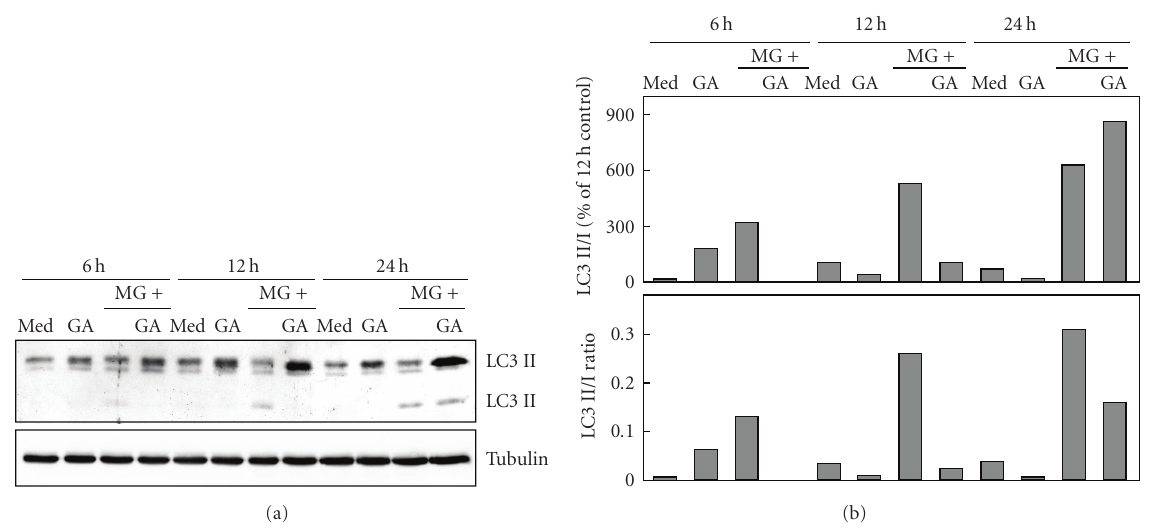
Figure 4: (a) Total proteins (20 μ g) of whole cell extracts were examined by western blot using antibodies against LC3 of control (med) cells, and cells exposed 0.25 μ M geldanamycin (GA) or 5 μ M MG-132 (MG) or their combination for 6, 12, and 24 hours. Tubulin was used to check the equal loading of proteins. (b) Quantifications of western blots and LC3 II/I